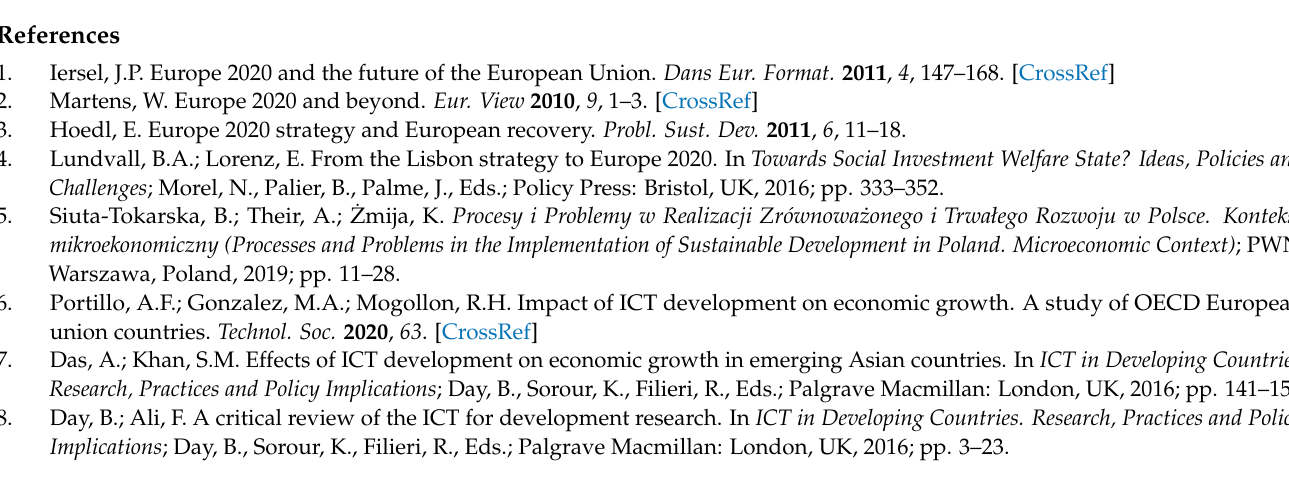
Use of Internet Integration of Digital Services